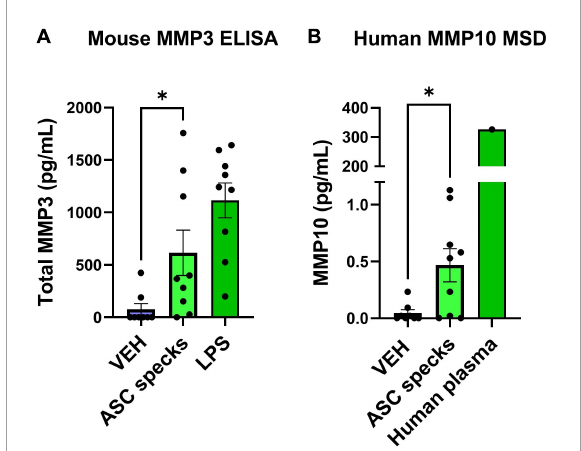
FIGURE2 Purified ASC speck aggregates stimulate the release of MMPs. ELISA and MSD were performed on supernatants derived from microglia after ASC speck or VEH stimulation. (A) Microglia treated with purified ASC specks (43.6 µ g/mL) for 12 h increased the release of MMP3 ( n = 9 wells/treatment). LPS treated microglia are shown and served as a positive control. (B) MMP10 is also released by these cells as determined by MSD ( n = 9–8 wells/treatment). One human plasma sample served as a positive control. The values shown are derived from three independent experiments in which there were three technical replicates, or wells, per treatment. Each independent experiment is shown in the graph and was statistically analyzed together. Values are reported as mean ± SEM; Unpaired Student’s t -test; ∗ P ≤